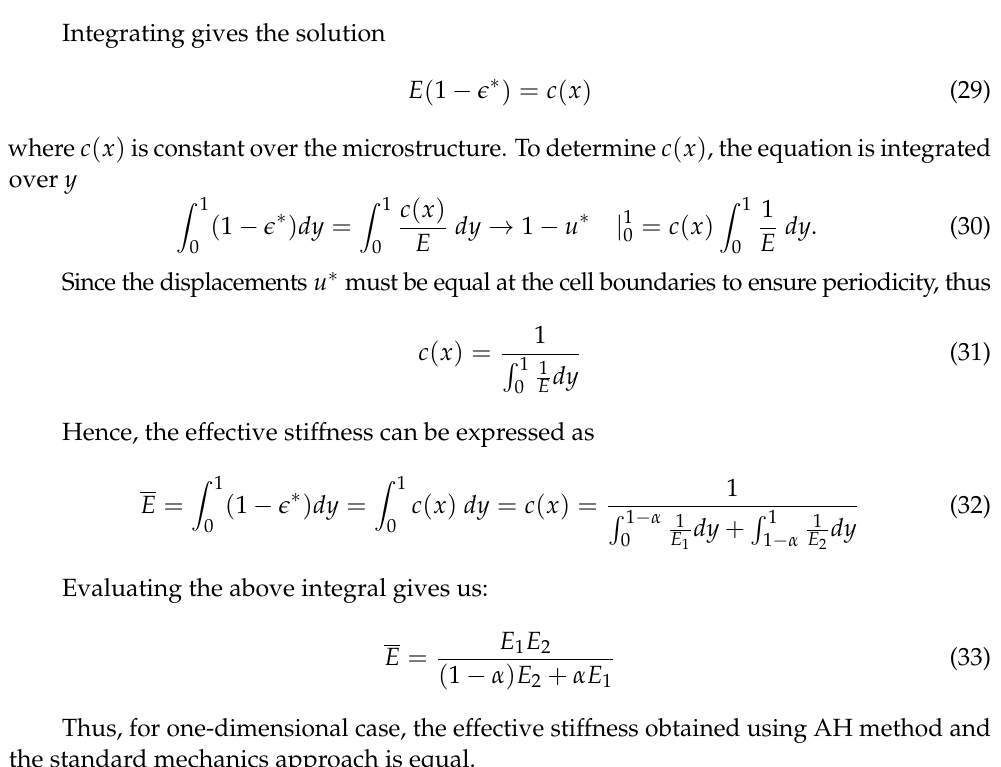
Figure 7. Composite bar used for the one-dimensional analysis [63].